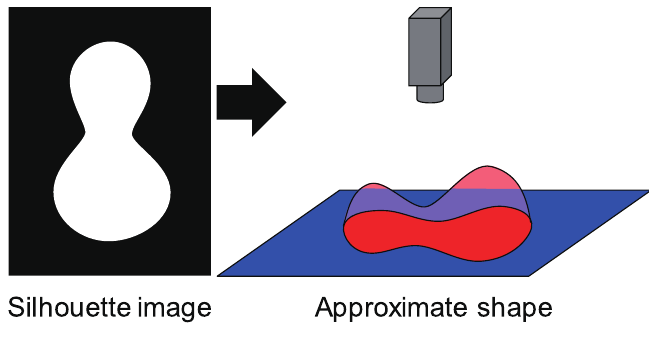
Figure 3. Approximate shape used for initial guess to surface normal. The shape is inflated using the silhouette of the object